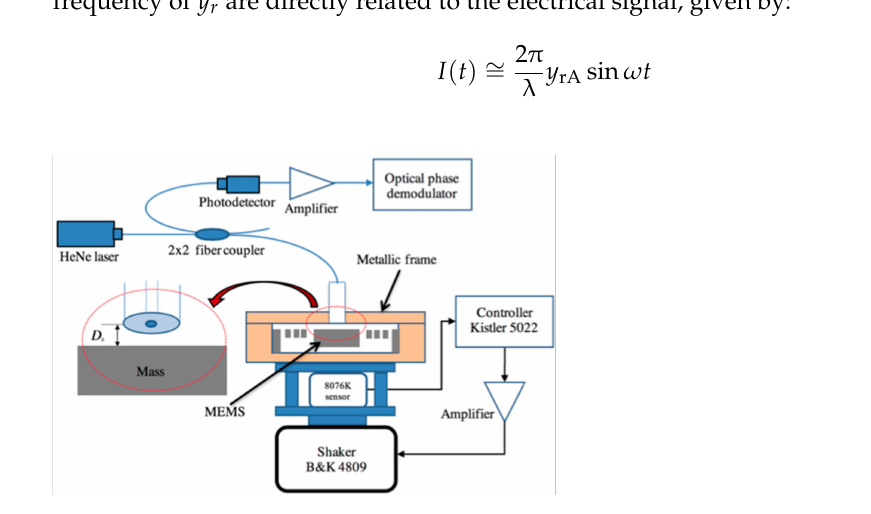
Figure 11. Experimental setup used to run the optical characterization of the MOEMS